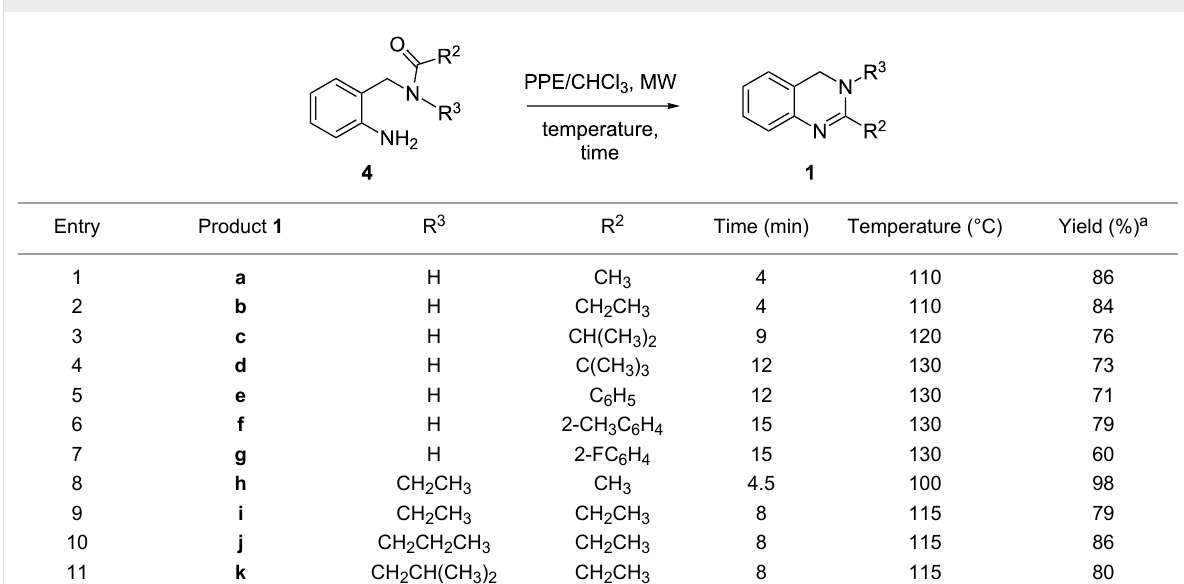
Table 3: Synthesis of 3,4-dihydroquinazolines 1